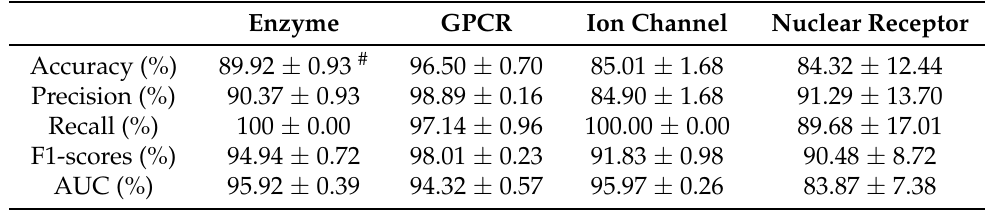
Table 3. Prediction results of the proposed method.